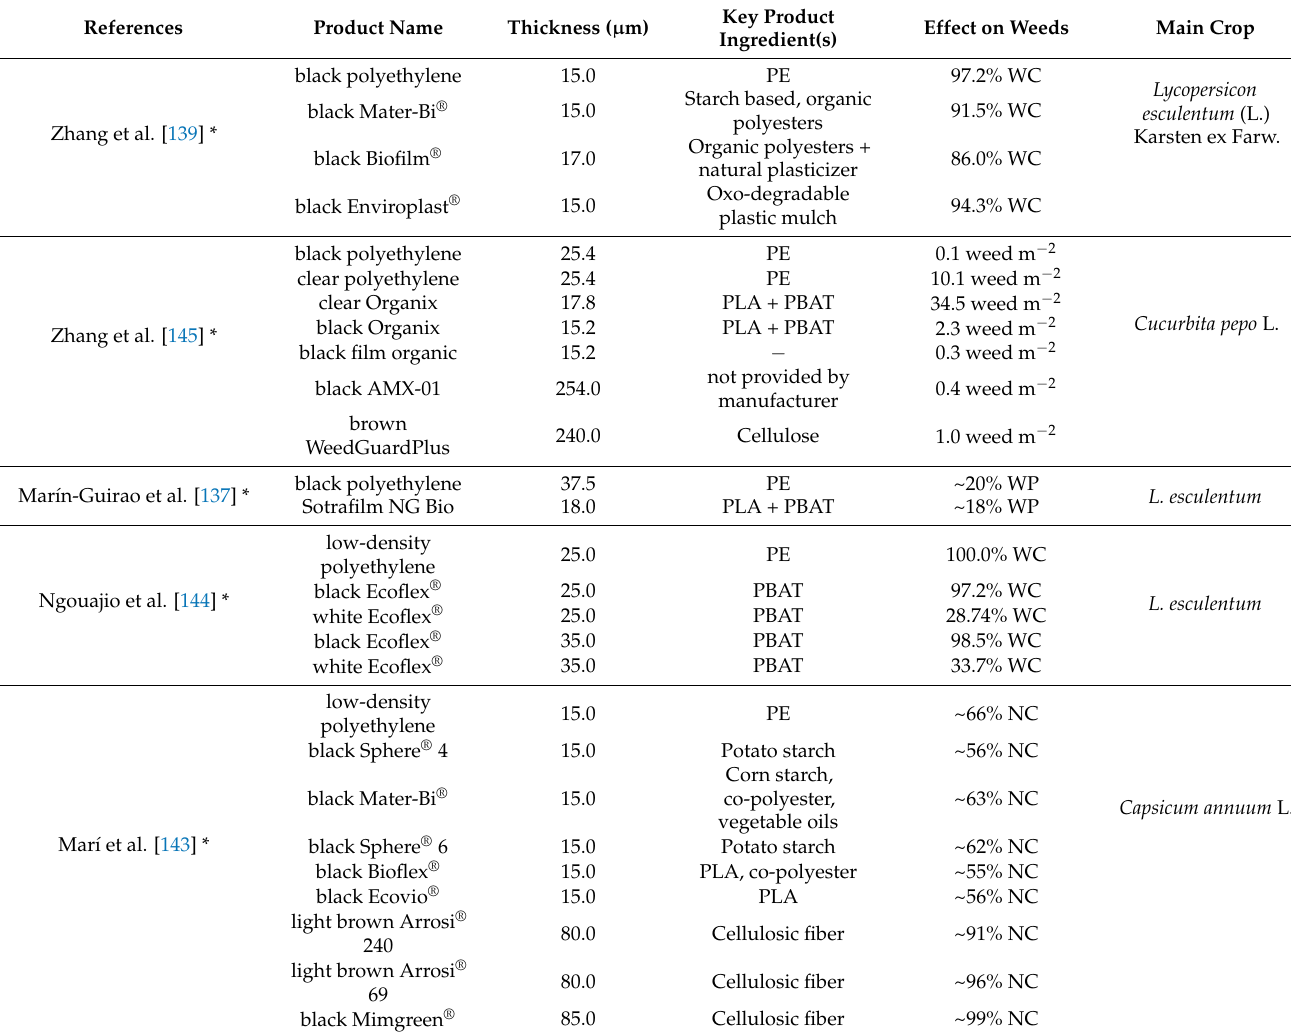
Table 6. Weed-suppressive ability of different bio-plastic film mulches vs. polyethylene